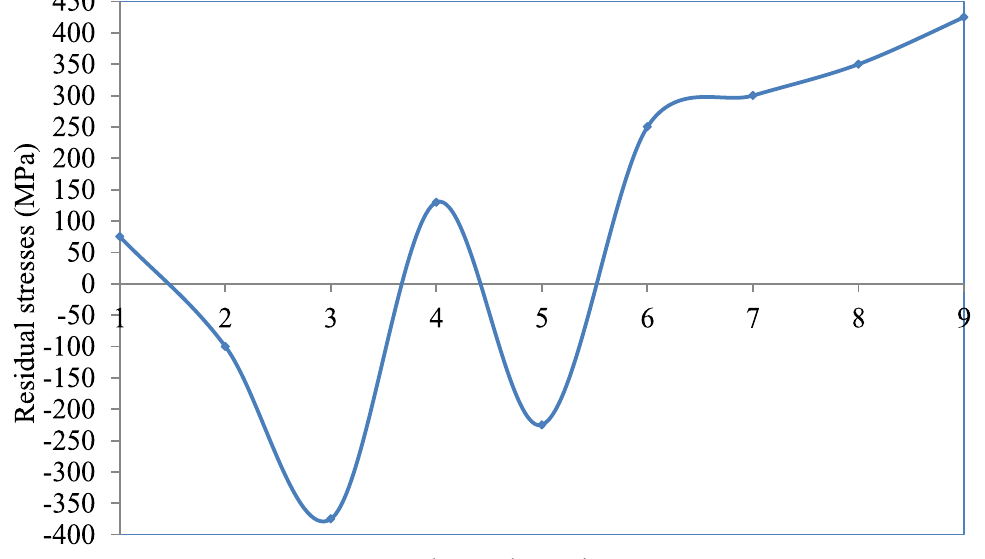
Fig. 14. Residual stresses at with respect to Experimental